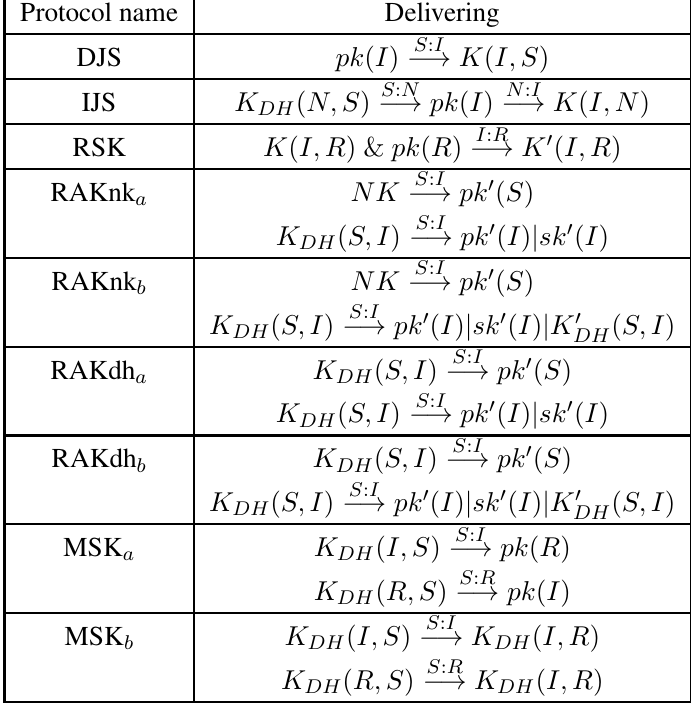
Figure 8. Key dependency for our protocols. K delivered by A to B and encrypted with K